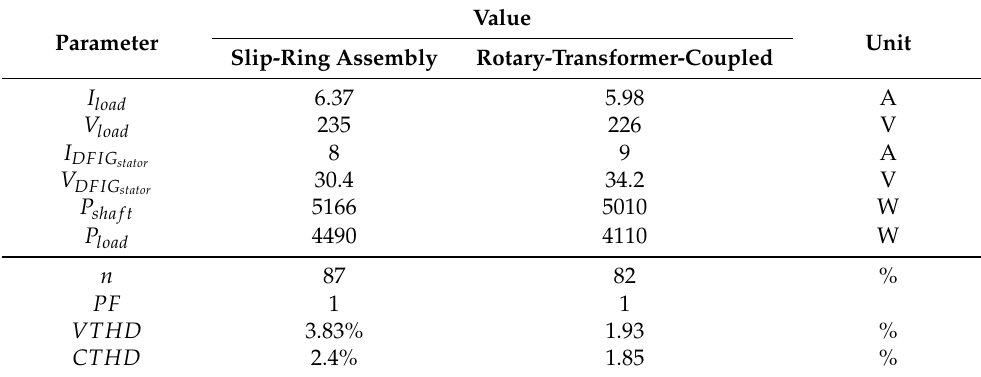
Table 10. RDFIG with slip rings vs. rotary transformer–RDFIG testing Parameter